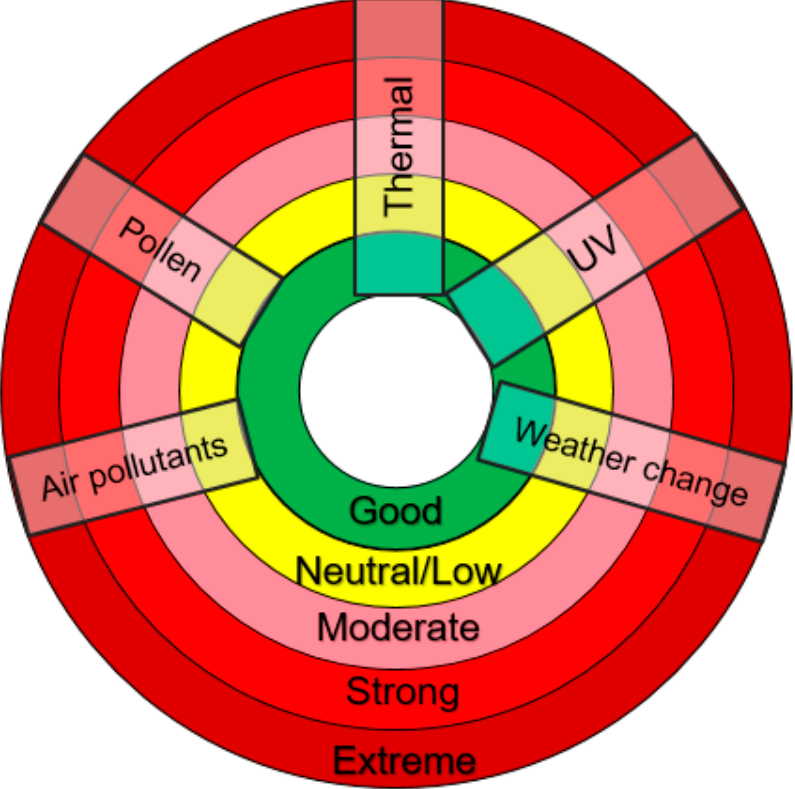
Figure 6. Classification approach for single and general visualization.